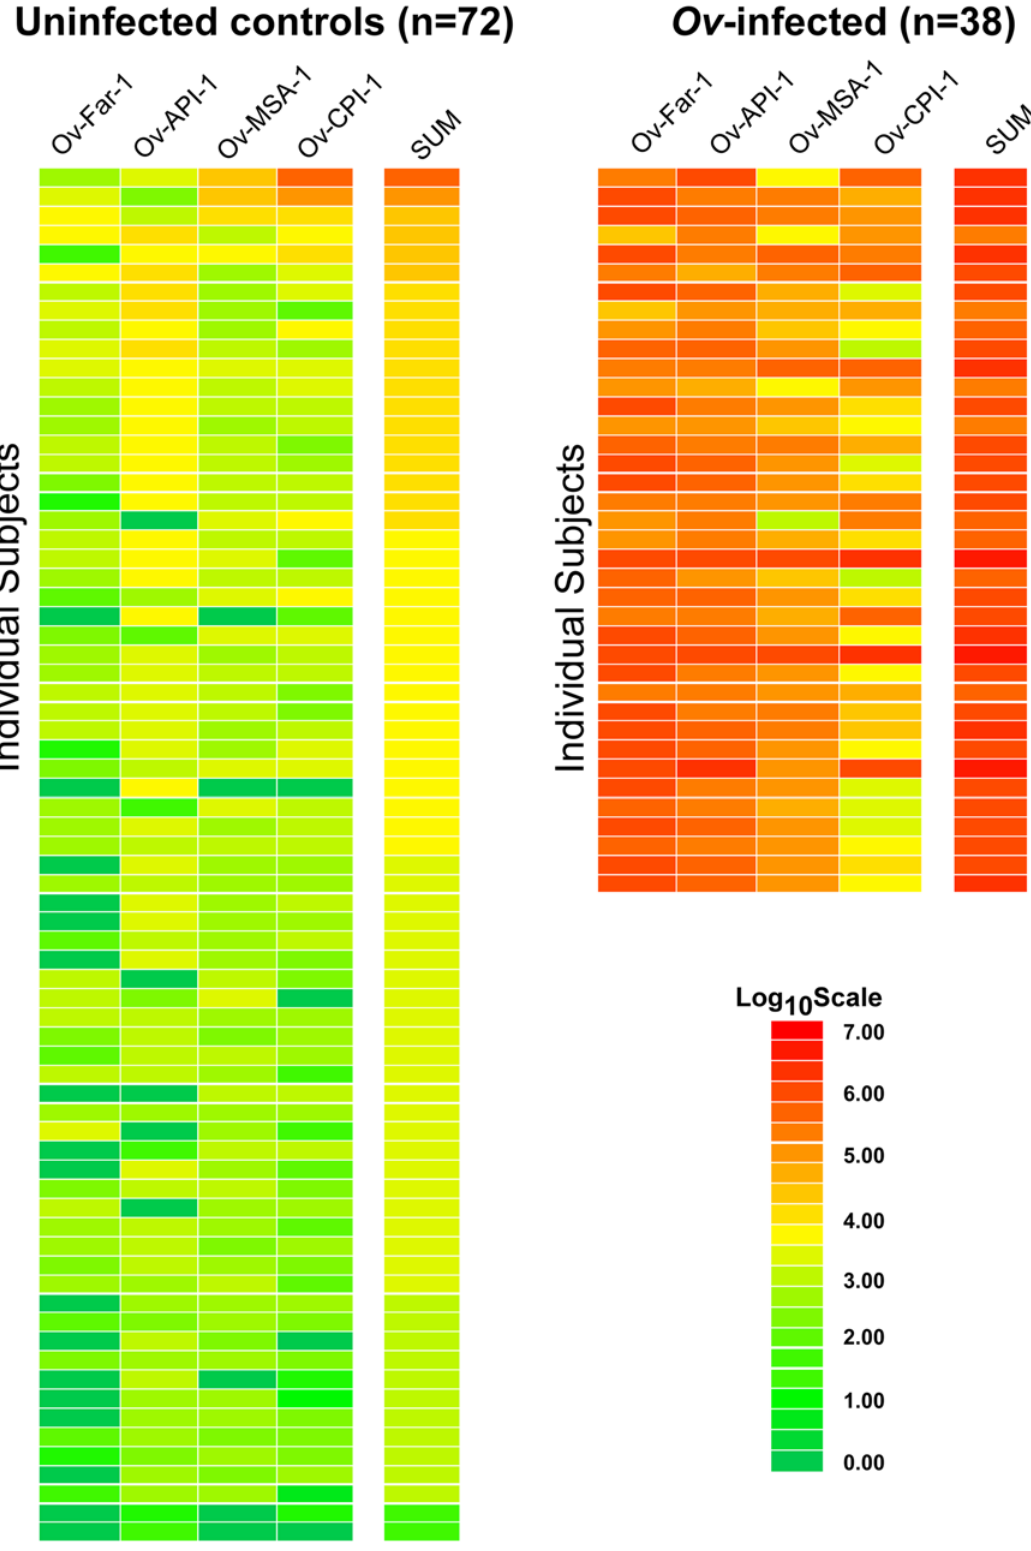
Figure 1. Heat map representation of patient antibody profiles to the 4 Ov antigens. The antibody levels for each serum were log 10 transformed and then the levels were color-coded as indicated by the log 10 scale on the left, in which signal intensities range from red to green indicating high (red) and low (green) titers. The samples were rank ordered from highest to lowest based on the sum of the antibody titers to the 4 antigen panel. The samples on the left are from uninfected, while the samples on the right are Ov -infected sera.